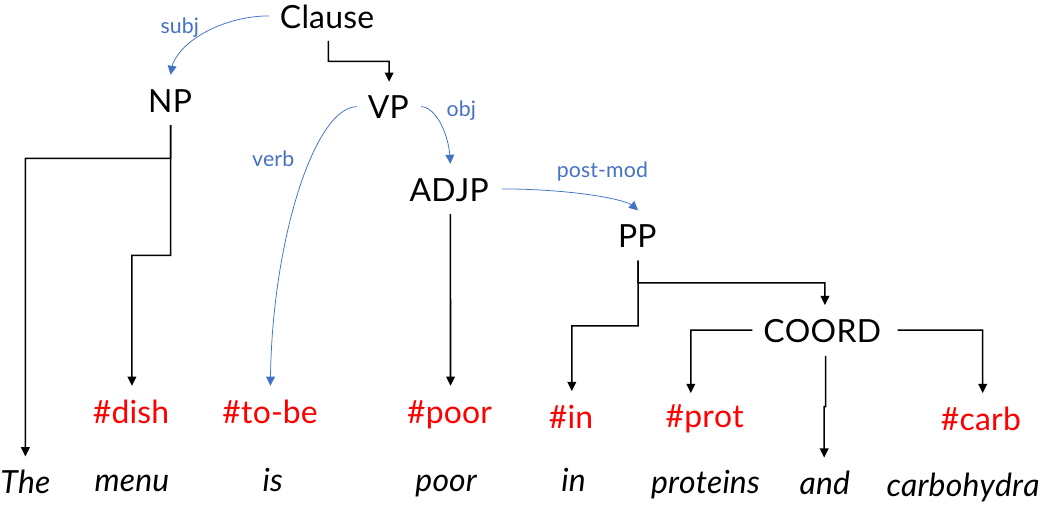
Figure 7. The quasi-tree obtained by using set-aggregation on the quasi-trees in Figure